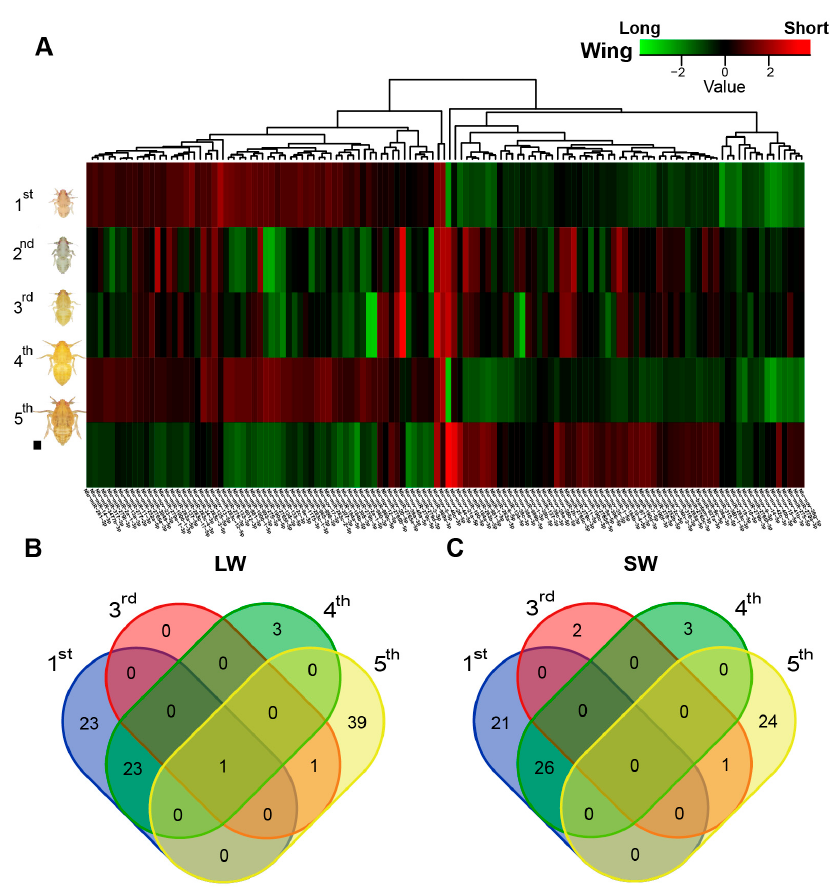
Figure 2. Differentially expressed miRNAs between LW and SW strains. ( A ) Heatmap of differentially expressed miRNAs between LW and SW strains. Green indicates miRNAs more highly expressed in the LW strain. Red indicates miRNAs more highly expressed in the SW strain. ( B ) and ( C ) Venn diagrams showing the overlap of miRNAs more highly expressed in the LW ( B ) and SW ( C ) strains at different instar stages (Differential expression analysis by DESeq2, adjusted p -value < 0.05, fold change > 2).